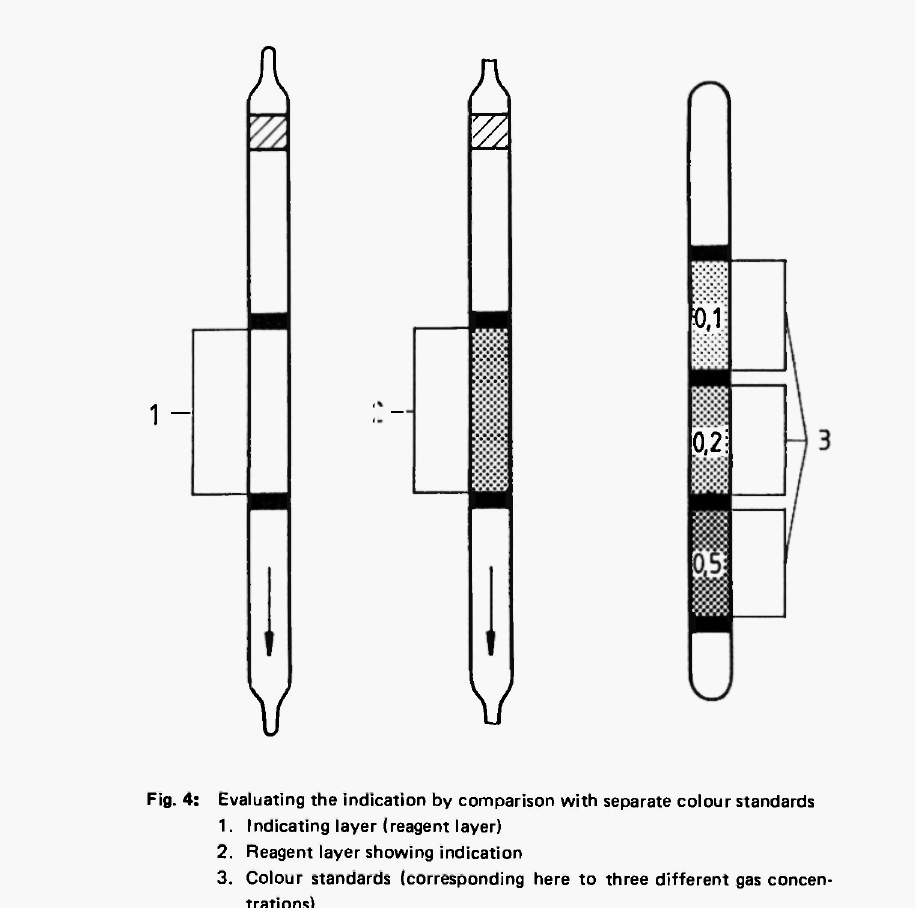
Fig. 4: Evaluating the indication by comparison with separate colour